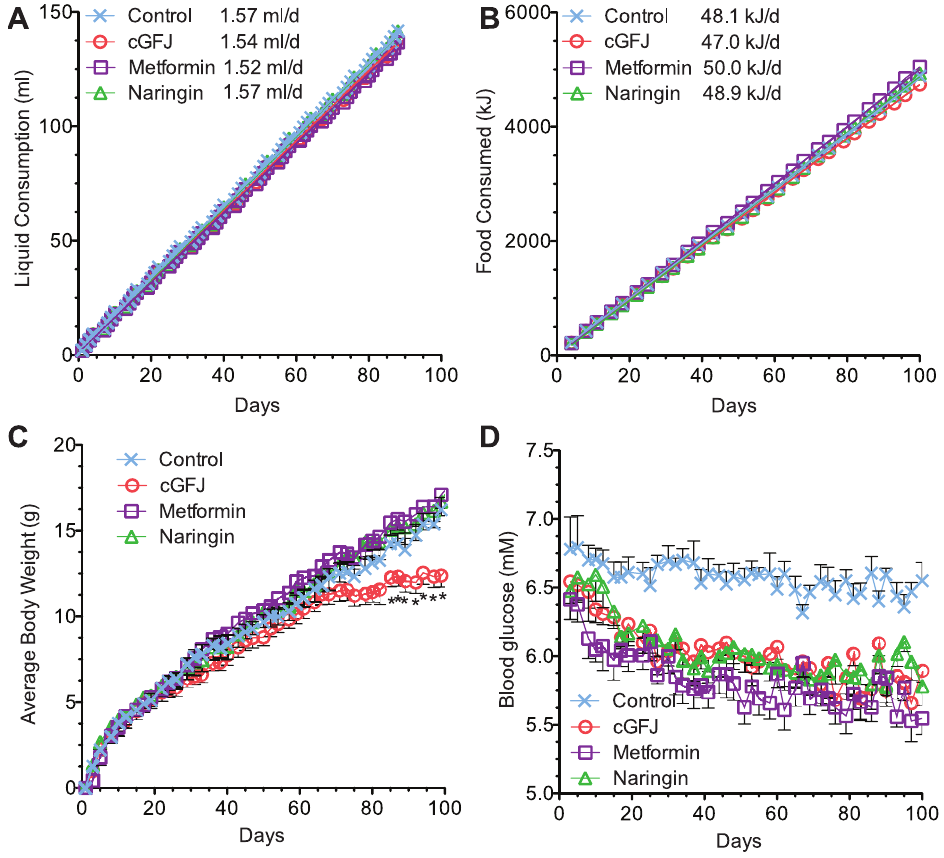
Figure 6. Comparison of metabolic effects of cGFJ, naringin, and metformin. Mice fed a HFD were given cGFJ, water containing naringin or metformin, or control water for 106 d: A) cumulative liquid consumption and rates based on linear regression. Slopes did not differ significantly; B) cumulative food consumption and rates based on linear regression. Slopes did not differ significantly; C) total body weights. 2way ANOVA with Bonferroni posttests showed that treatment and time had a significant effect (p , 0.0001) on body weight. Bonferroni posttests only showed significant differences in body weight between the control and cGFJ group form 92 onward but not for any of the other groups; D) blood glucose. 2way ANOVA with Bonferroni posttests showed that treatment and time had a significant effect (p , 0.0001) on blood glucose levels. Bonferroni posttests comparisons to the water control group showed significant differences for cGFJ and naringin starting day 27 and metformin starting day 8. Differences between cGFJ, naringin, and metformin were non-significant at all time